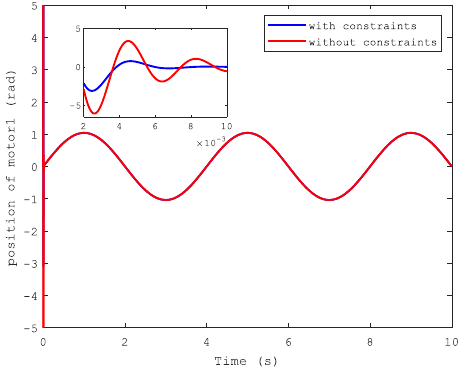
Figure 6. Position of motor 1.